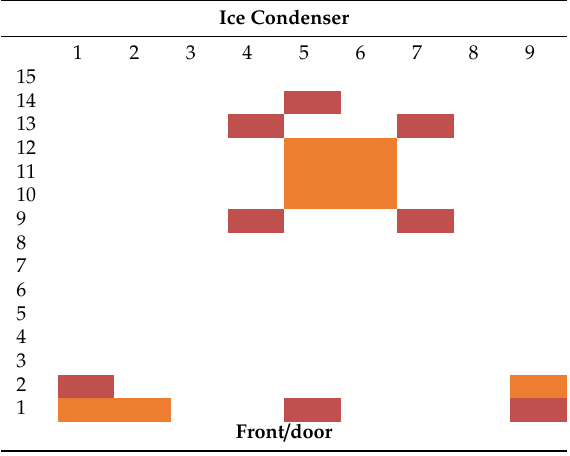
Table A2. Position of WTMplus sensors (red) and weighed vials